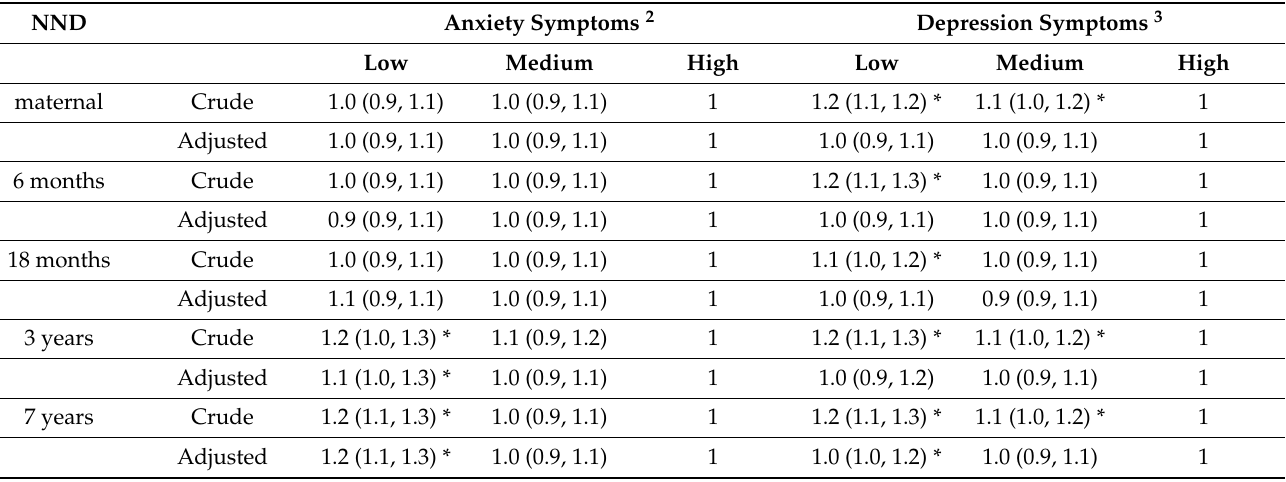
Table 5. Associations between categories of NND as total score and higher levels of anxiety and depression symptoms. Logistic regression (Crude and Adjusted 1 ).